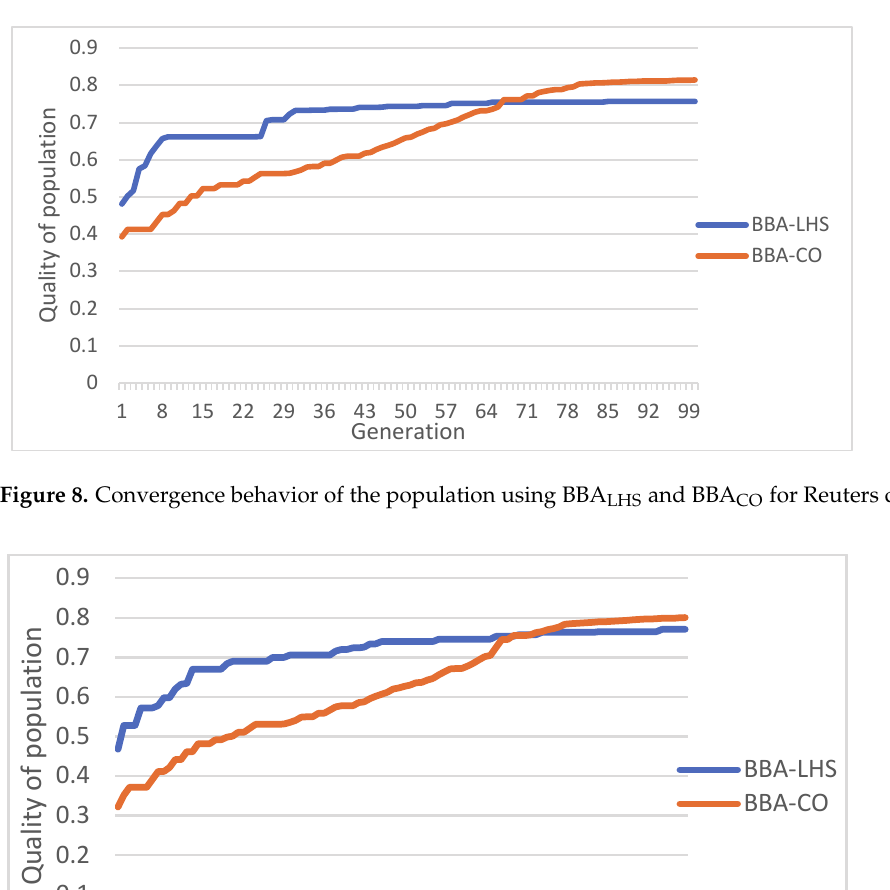
Figure 9. Convergence behavior of the population using BBA LHS and BBA CO for WebKB dataset. It can be noted that the population of BBA CO converged slower than the population of BBA LHS due to controlling diversity during the search process. However, the average quality of the solutions at the end of the optimization in BBA CO is higher than in BBA LHS . From the results of the convergence, it is clear that in BBA LHS , the population converge faster and stagnate in the first third of the search process, while in BBA CO the conver ‐ gence is slower and the stagnation occurs by the last third of the search process. As a conclusion, BBA LHS initialization could be the best choice if the purpose was improving the whole population within a small number of generations, while BBA CO is better if the purpose is controlling the diversity and obtaining a better final solution. Figures 10 and 11 compare the convergence of five randomly selected solutions using BBA LHS and BBA ‐ CO in Reuters and WebKB datasets, respectively.